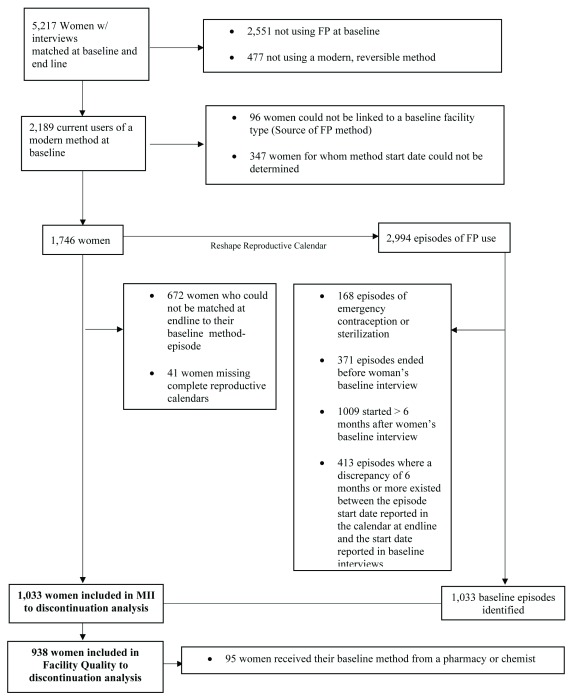
Participant Diagram.